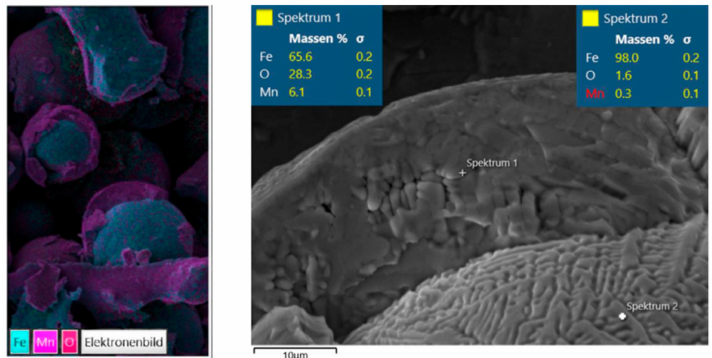
− 1 , pulsed direct current).